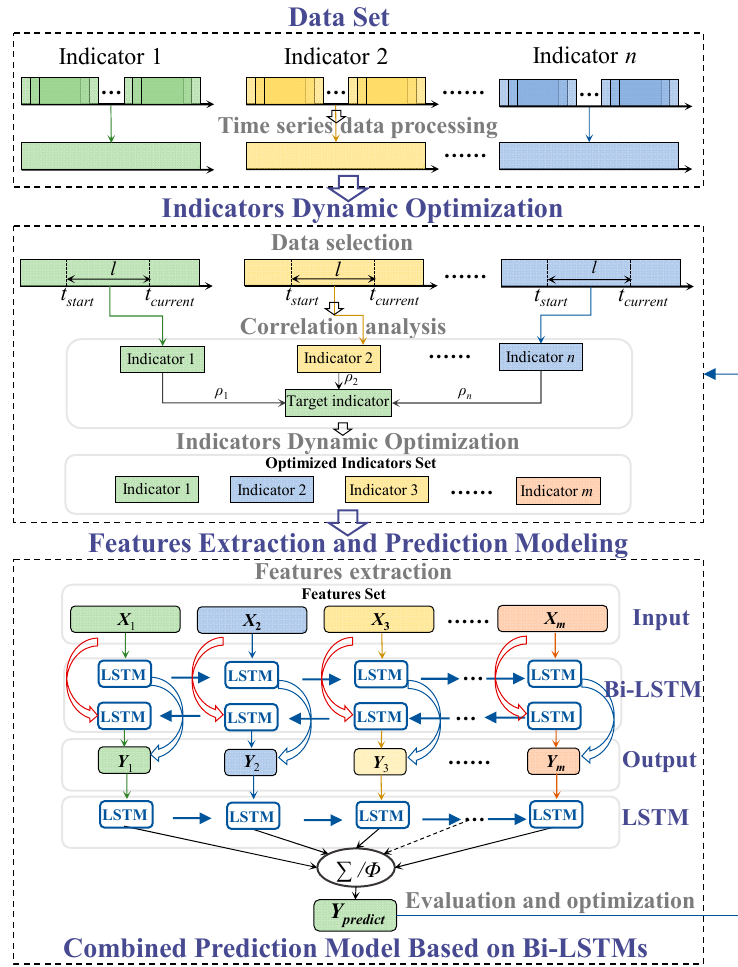
Figure 4. Combined prediction method of gas concentration based on indicators dynamic optimiza- tion and Bi-LSTMs.